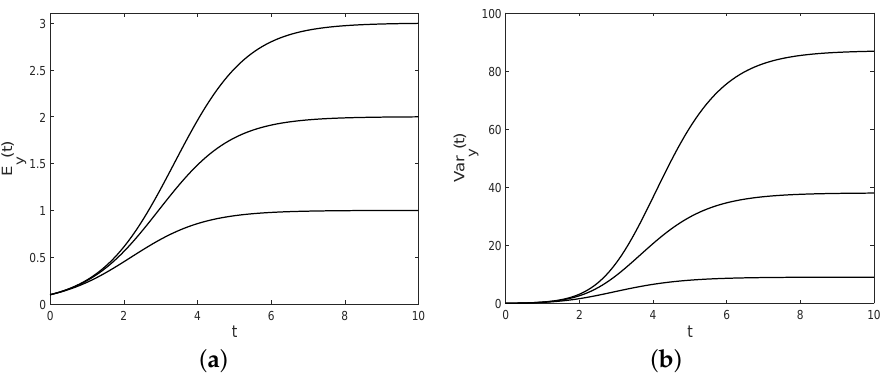
Figure 9. ( a ): The conditional mean (26) and ( b ): the conditional variance (28) are plotted for y = 0.1, r = 1, and C = 1, 2, 3 (from bottom to top). For the variance the limits are 9, 38, 87,